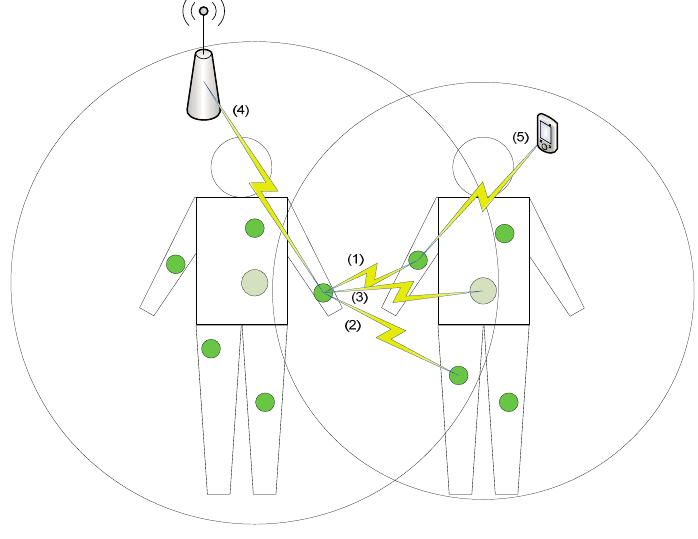
Figure 1. Interference in